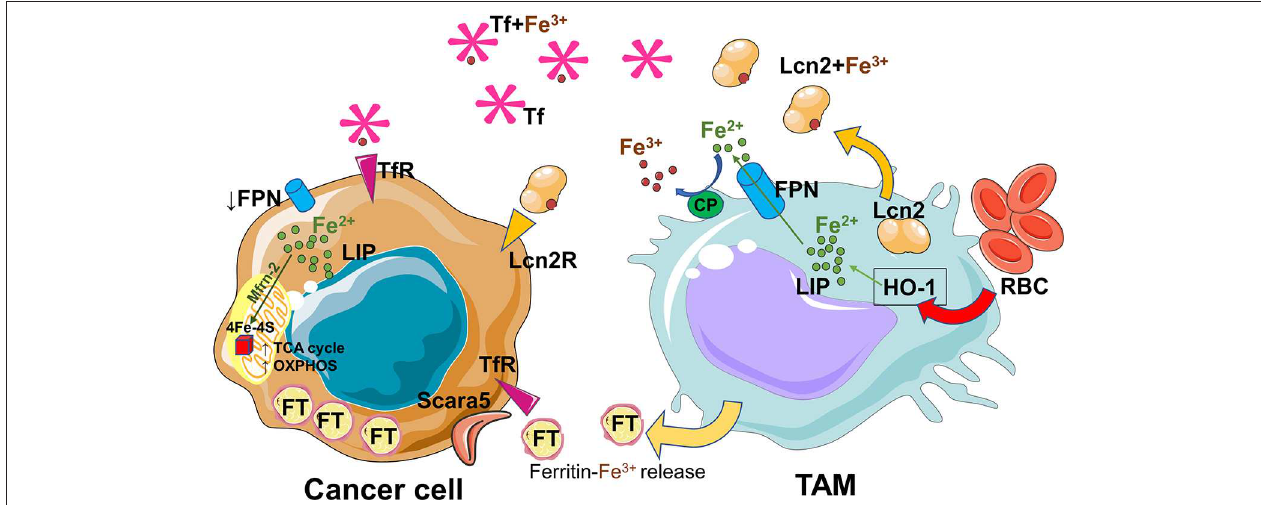
FIGURE 2 | Iron recycled and released by TAMs sustains the cancer progression. The pro-tumoral/anti-inflammatory macrophages adopt an iron-export phenotype. The released iron is absorbed by cancer cells, driven to mitochondria via mitoferrin-2 (Mfrn-2) and delivered to Fe-S clusters proteins essential for mitochondrial respiration and the activities of TCA cycle enzymes. TAMs rely on uptake of senescent red blood cells (RBC) and on the activity of heme oxygenase 1 (HO-1) in order to recycle heme-iron and increase labile iron pool (LIP). Iron can be released via ferroportin (FPN) and after ceruloplasmin (CP) activity loaded onto circulating transferrin (Tf) for its uptake by cancer cells via the transferrin receptor (TfR). Alternatively, TAMs can use lipocalin-2 system or release ferritin to transfer iron. During cancer progression, tumor cells increase iron storage by ferritin (FT) overexpression, and iron uptake by upregulation of the ferritin light chain binding protein